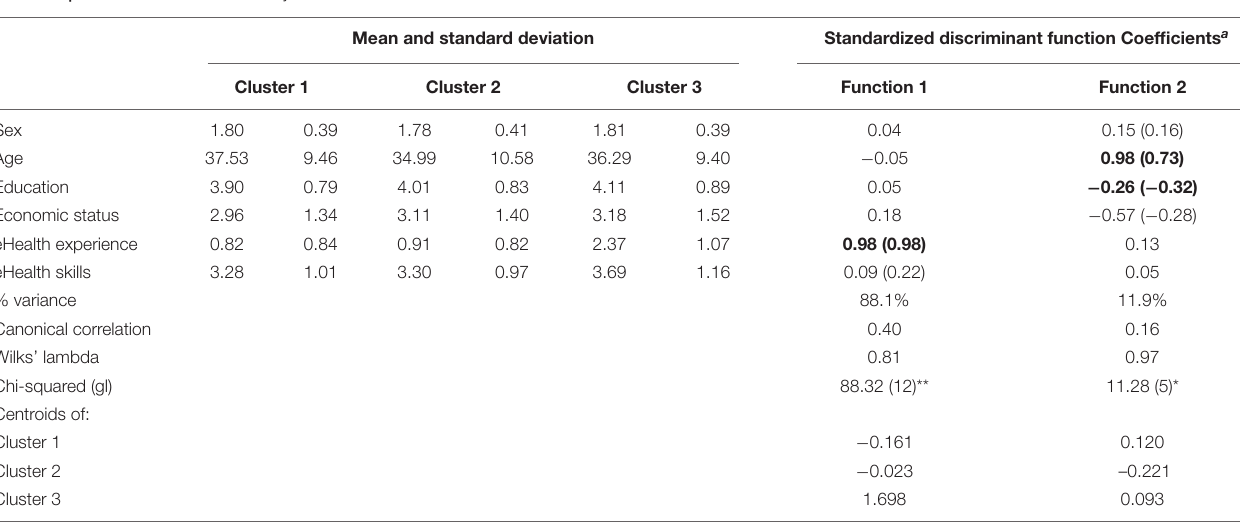
TABLE 4 | Results of discriminant